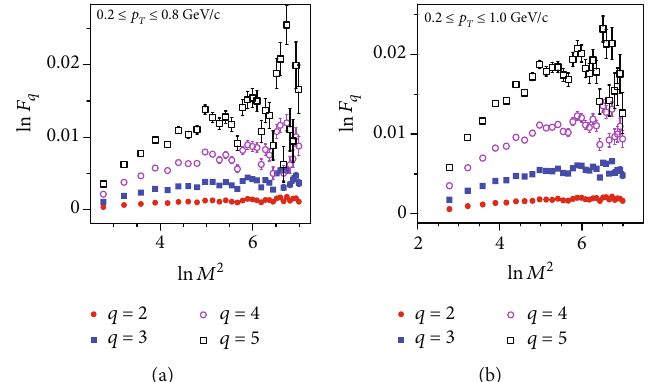
M 2 ) for EPOS3-hydro events for the p